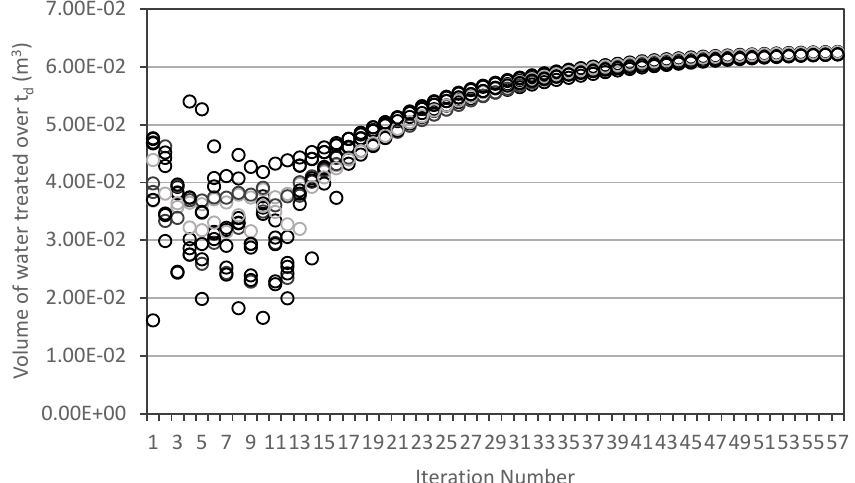
Figure 16. Convergence trend for the reliability parameter r ( X ) .